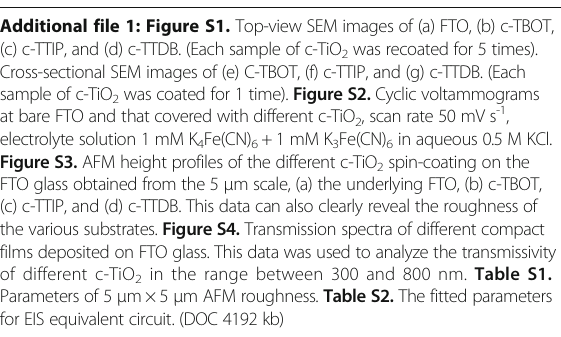
Additional file